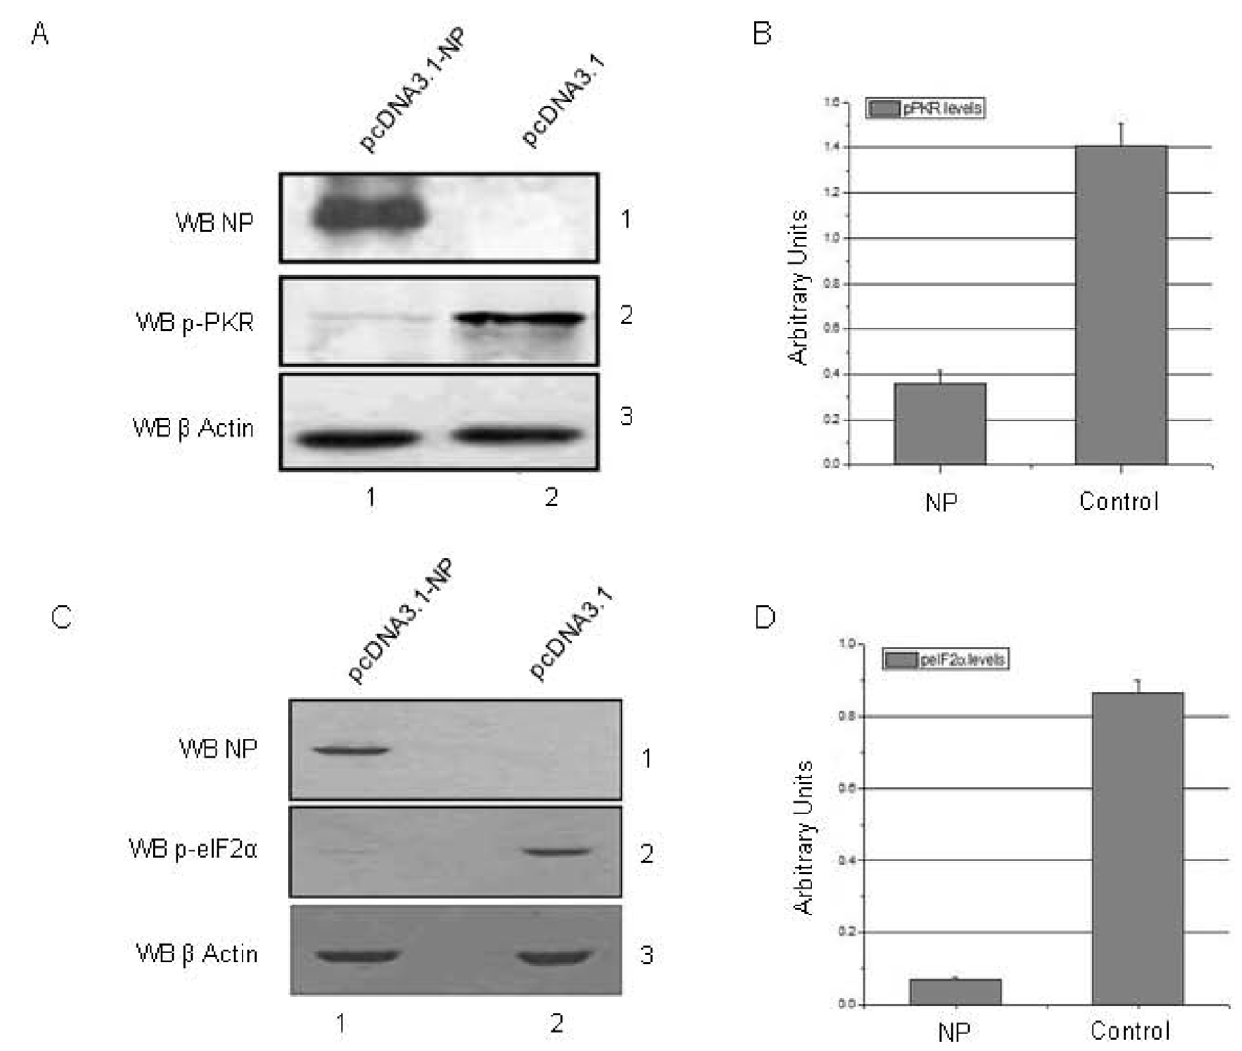
Figure 5. NP expression in mammalian cells leads to downreglation of PKR and eIF2 a phosphorylation. HEK293T cells were transfected with NP expressing plasmid (pcDNA3.1-NP) or control plasmid (pcDNA3.1). Cells were harvested at 36 hours post-transfection and cell lysates were subjected to western blotting analysis. A. Lane 1 of panel 2 shows significant downregulation of pPKR levels in NP transfected cells. Panel 1 shows NP expression level, whereas panel 3 shows equal loading trough b -Actin control. B. Figure shows graphical representation of relative pPKR levels as measured by western blotting followed by densitometric measurement in 3 independent experiments. Error bars represent standard deviation. C. Lane 1 of panel 2 shows significant downregulation of p-eIF2 a levels in NP transfected cells. Panel 1 shows NP expression level, whereas panel 3 shows equal loading trough b -Actin control. D. Figure shows graphical representation of relative p-eIF2 a levels as measured by western blotting followed by densitometric measurement in 3 independent experiments. Error bars represent standard